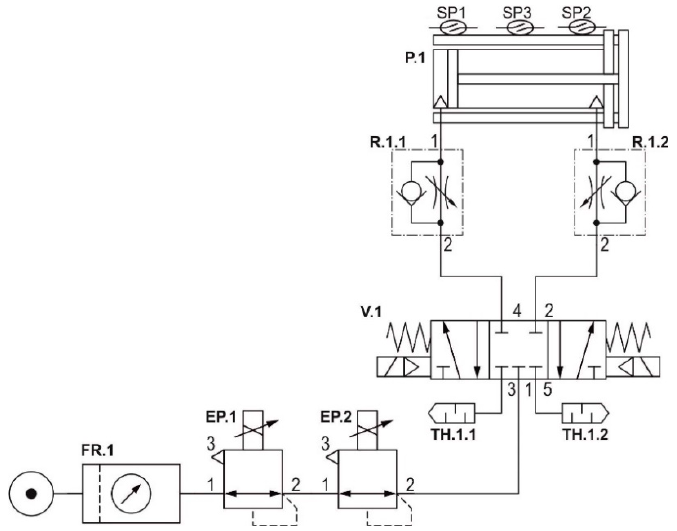
Figure 3. Pneumatic scheme of mechanical ventilator BreaThU.